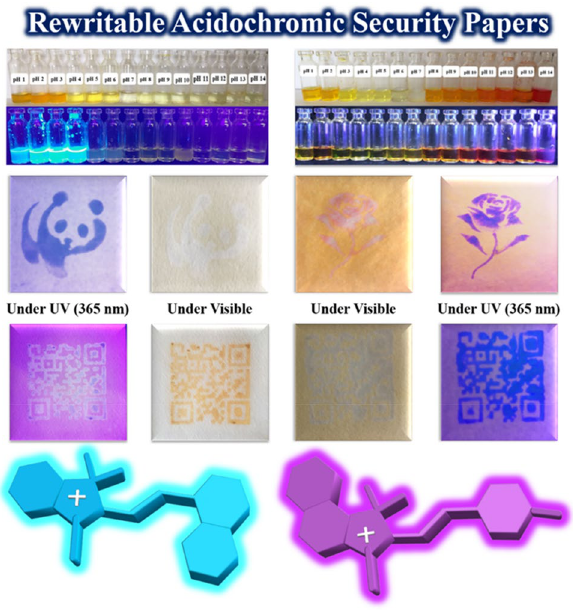
Figure 1. Oxazolidine derivatives for design of rewritable acidochromic security papers printable by acidic and alkaline